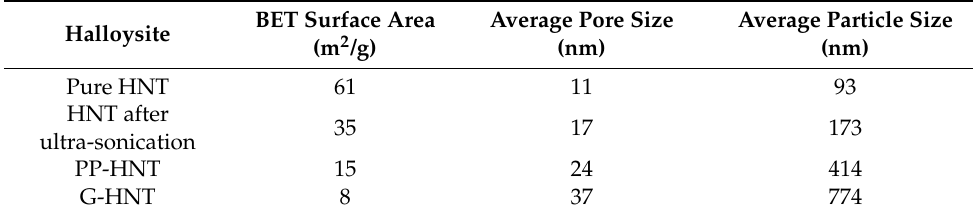
Table 1. Pure and modified halloysite